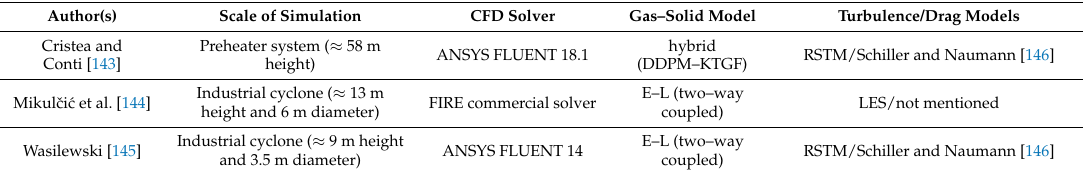
Figure 8. Predicted trajectories of particles of different diameters in an industrial-scale cyclone with a body diameter of 3.45 m. The trajectories are colored with particle temperature. The inlet gas and particle temperatures are 634 K and 611 K , respectively, and inlet solids mass loading is around 0.8 kg s /kg g [145]. Reproduced with permission from M. Wasilewski, Analysis of the effects of temperature and the share of solid and gas phases on the process of separation in a cyclone suspension preheater; published by Elsevier, 2016. Table 3. Selected CFD studies of industrial-scale cyclones operating at elevated temperatures, in chronological